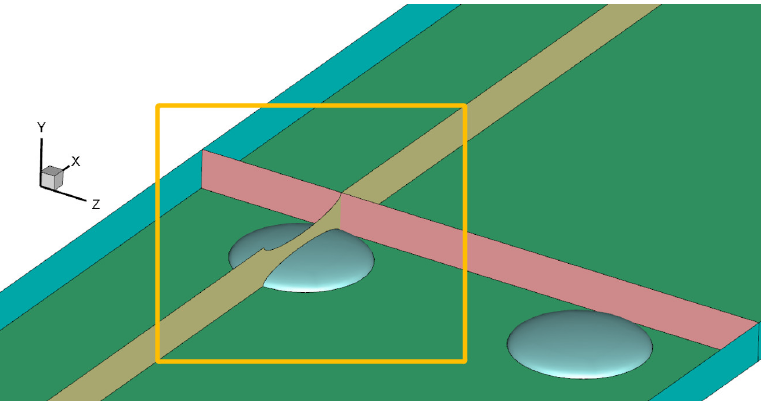
Figure 25. Middle and tail sections of the protrusion.